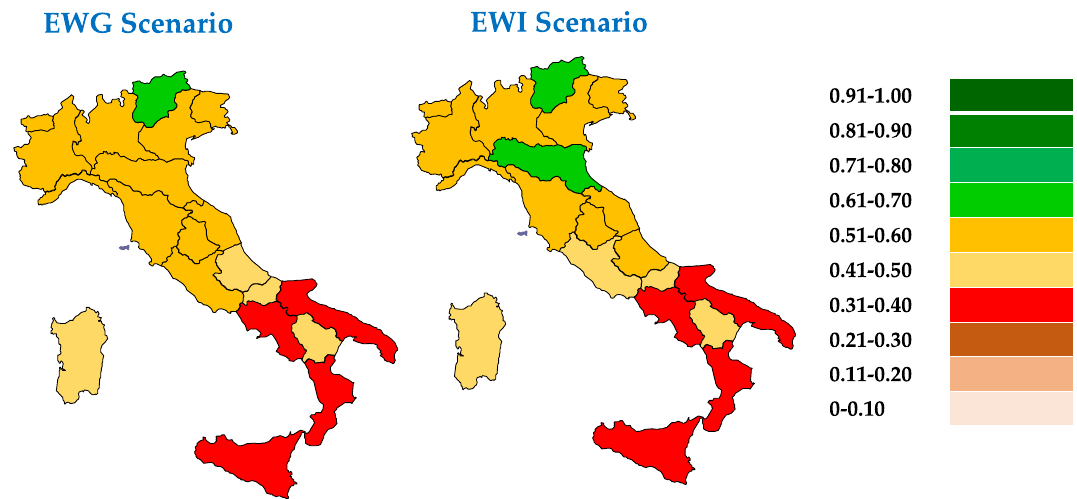
Figure 3. Sustainability Score in both EWG and EWI scenarios—a comparison among Italian